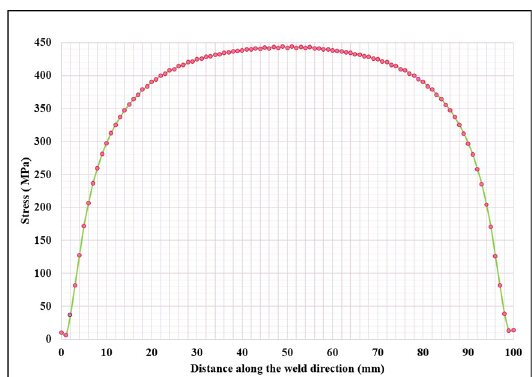
Figure 13 represents the residual stress distribution in the direction of welding. It is observed from the figure that the residual stress starts to increase when plasma torch is ignited and reaches a maximum value at the point where torch reaches centre position of the plate. The stress value starts to decrease gradually when torch moves away from centre of the plate along the direction of welding.